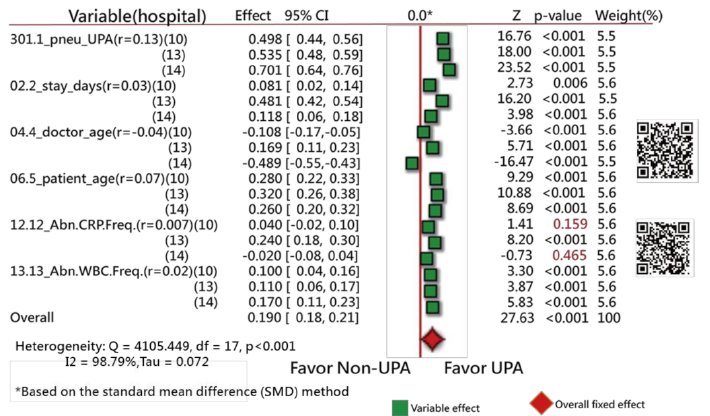
Figure 5. Comparison of hospital types between feature variables using a forest plot to present the interpretation based on the SMD method